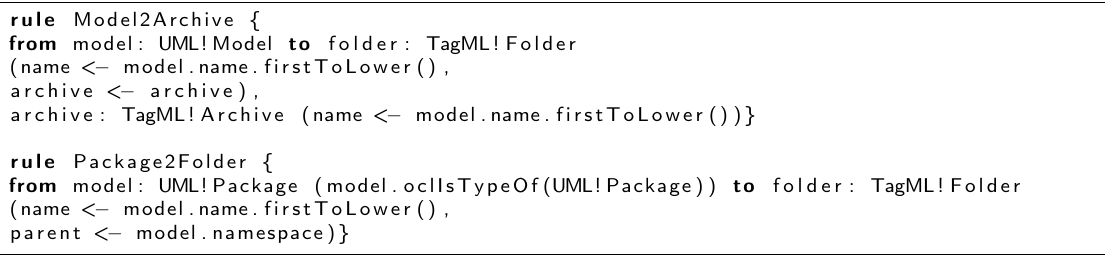
Figure 15. Transformation rules from Model to Archive and from Package to Folder in ATL.